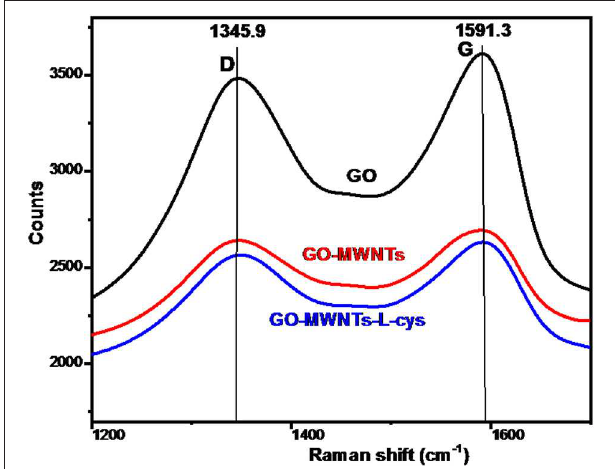
FIGURE 3 | Raman spectra of GO, GO–MWNTs, and GO–MWNTs–L-cys.